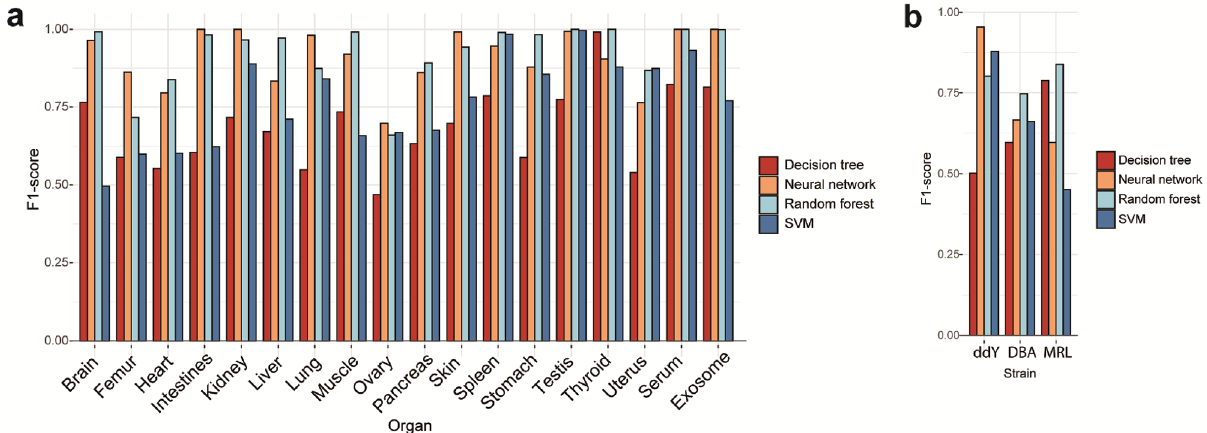
Figure 7. Machine learning analysis of the organ N -glycosylation patterns expands applicability of the mouse tissue glycome atlas. ( a ) The F1 scores in predicting organs by discriminant analysis using four machine learning algorithms with organ/tissue N -glycan profiles. The test data were randomly selected one of five replicates by stratified sampling, while other four of five samples were used as learning data. ( b ) The F1 scores in predicting mouse strains by discriminant analysis using four machine learning algorisms with lung N -glycan profiles (Tables S2 and S4). Red: decision tree, orange: neural network, sky-blue: random forest, blue: SVM. ddY: outbred mouse Slc:ddY, DBA: inflammatory inbred mouse DBA/2Crslc, MRL: the model mouse of systemic lupus erythematosus (SLE) syndrome